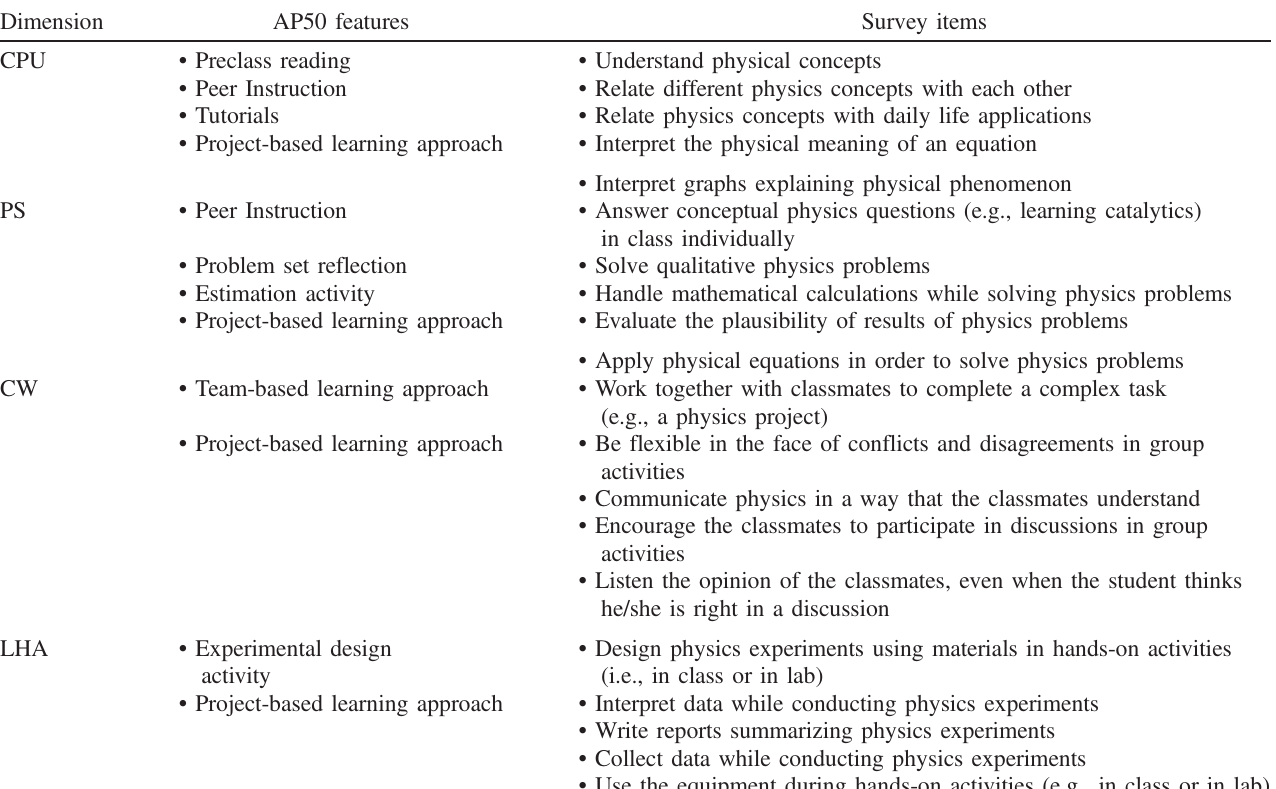
TABLE II. Mapping of survey items onto the AP50 features, organized into the four dimensions of physics